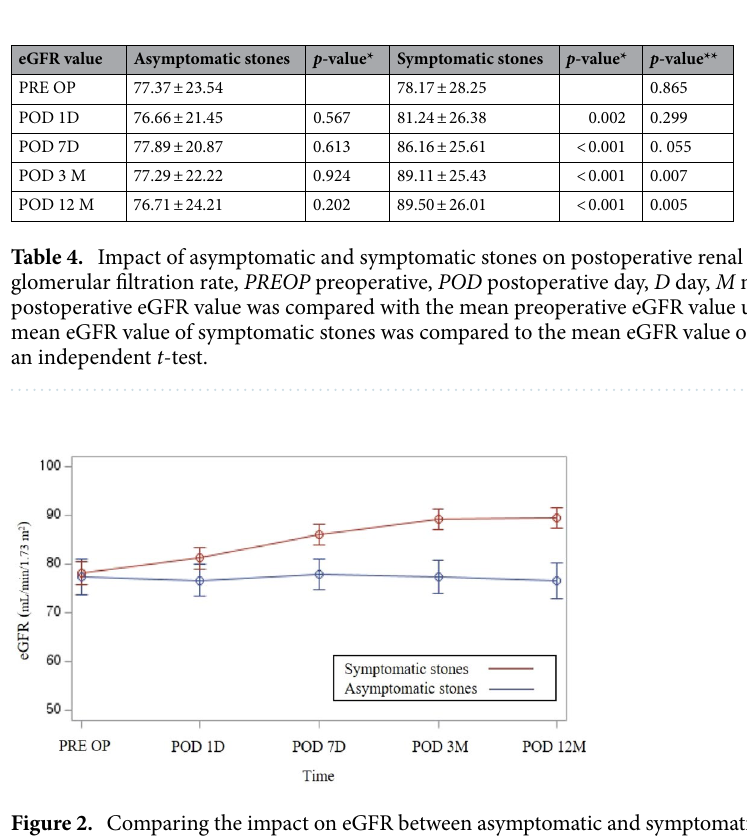
Figure 2. Comparing the impact on eGFR between asymptomatic and symptomatic ureteral stones.